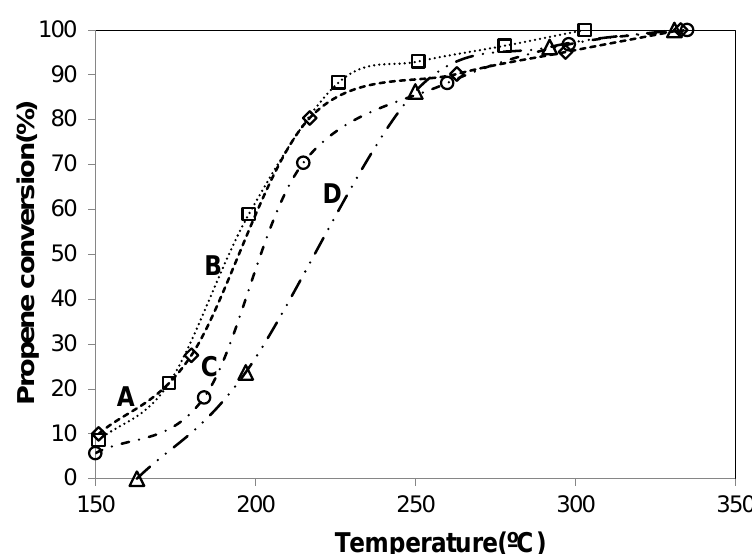
Figure 7. Catalytic activity of H 2 pre-treated catalysts. (A) Pd-ZnAl red ; (B) PdCo-ZnAl red ; (C) PdCu-ZnAl red ; (D) PdCo-ZnAl.